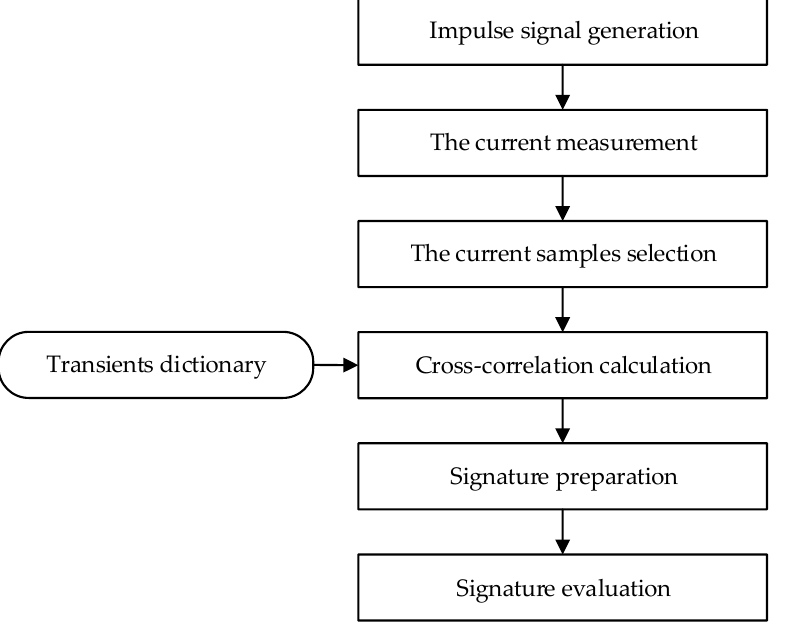
Figure 2. Block diagram of the HF-GEN method.